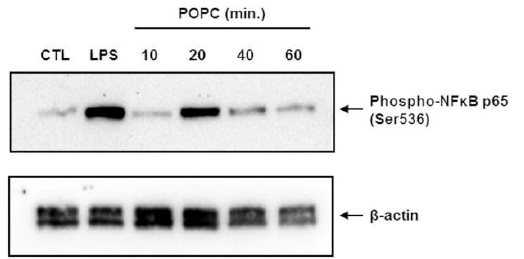
Figure 8. POPC liposome treatment promotes the phosphorylation of the NF-kb p65 subunit. J774A.1 cells were treated with POPC liposomes (2 × 10 5 per cell) for different periods of time, as indicated. Control cells received PBS vehicle only (no liposome). Cells treated with 100 ng/mL LPS for 10 min were used as positive controls. Cells were lysed in the RIPA lysis buffer containing serine/threonine phosphatases inhibitors, and 60 µ g of total protein was resolved by SDS-PAGE. After transfer, Blots were probed with a rabbit anti-phospho-NF-kB p65 mAb followed by HRP-conjugated goat anti-rabbit IgG antibodies. As a loading control, blots were also probed with mouse anti- β -actin monoclonal antibodies followed by goat anti-mouse HRP-conjugated IgG secondary